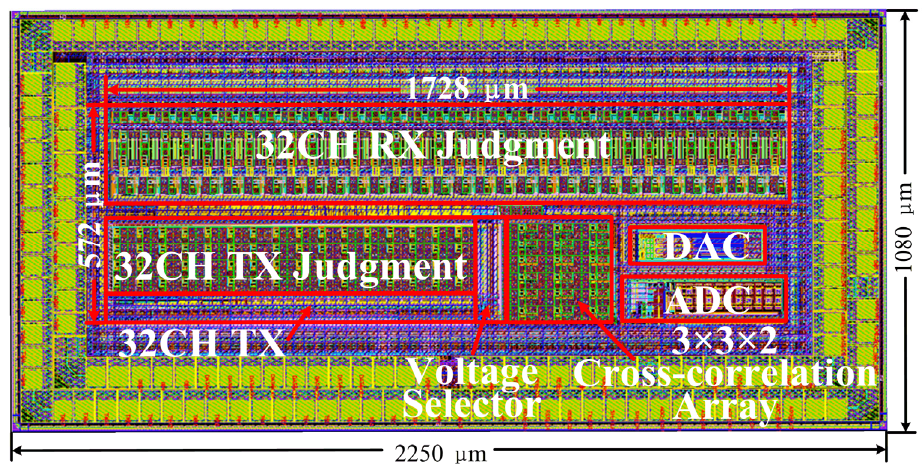
Figure 9. The layout of the proposed low-computing-complexity cross-correlation AFE.